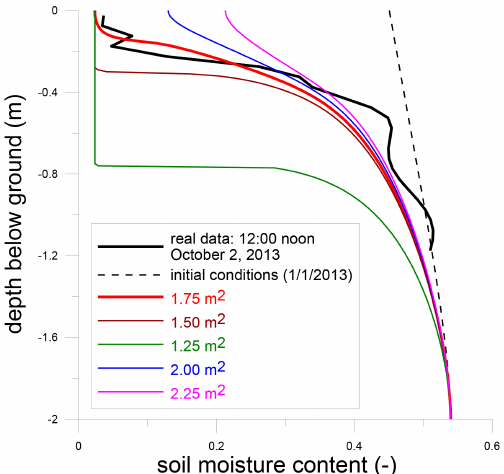
Figure 7. Results of 1-D Richards’ equation simulations of the en- tire year 2013 up to 3 October 11:00LT, i.e. in correspondence of the background ERT acquisition (the thick black line represents the resulting estimated moisture content profile obtained from averag- ing horizontally the central square metre of the ERT control vol- ume). The different simulated curves correspond to different as- sumed areas of root water uptake (RWU), and show how 1.75m 2 is the area that allows one to match the observed real profile with good accuracy. Note also the high sensitivity of the results to the estimated root uptake area.